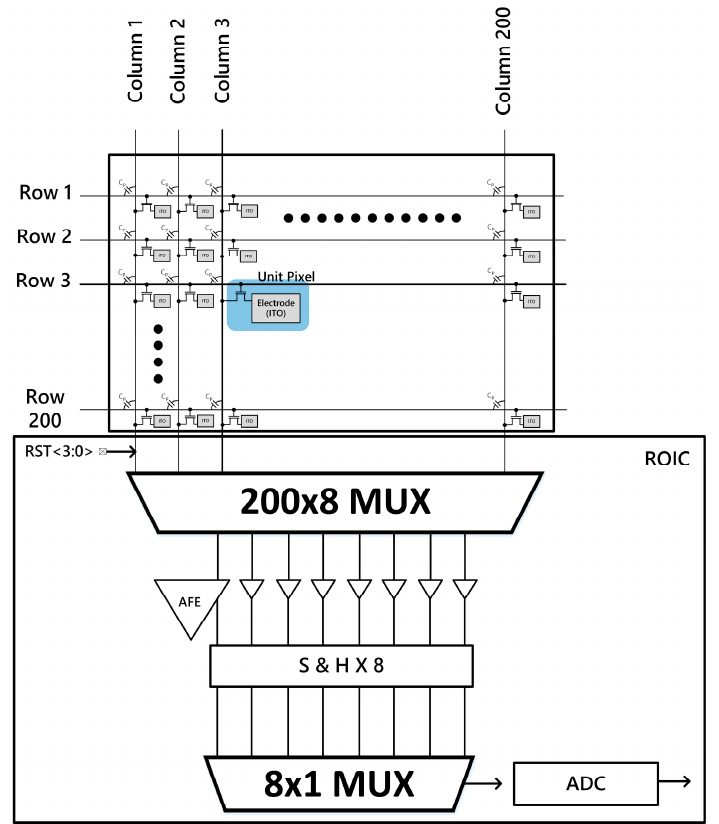
Figure 1. Block diagram of the proposed finger print sensor system.